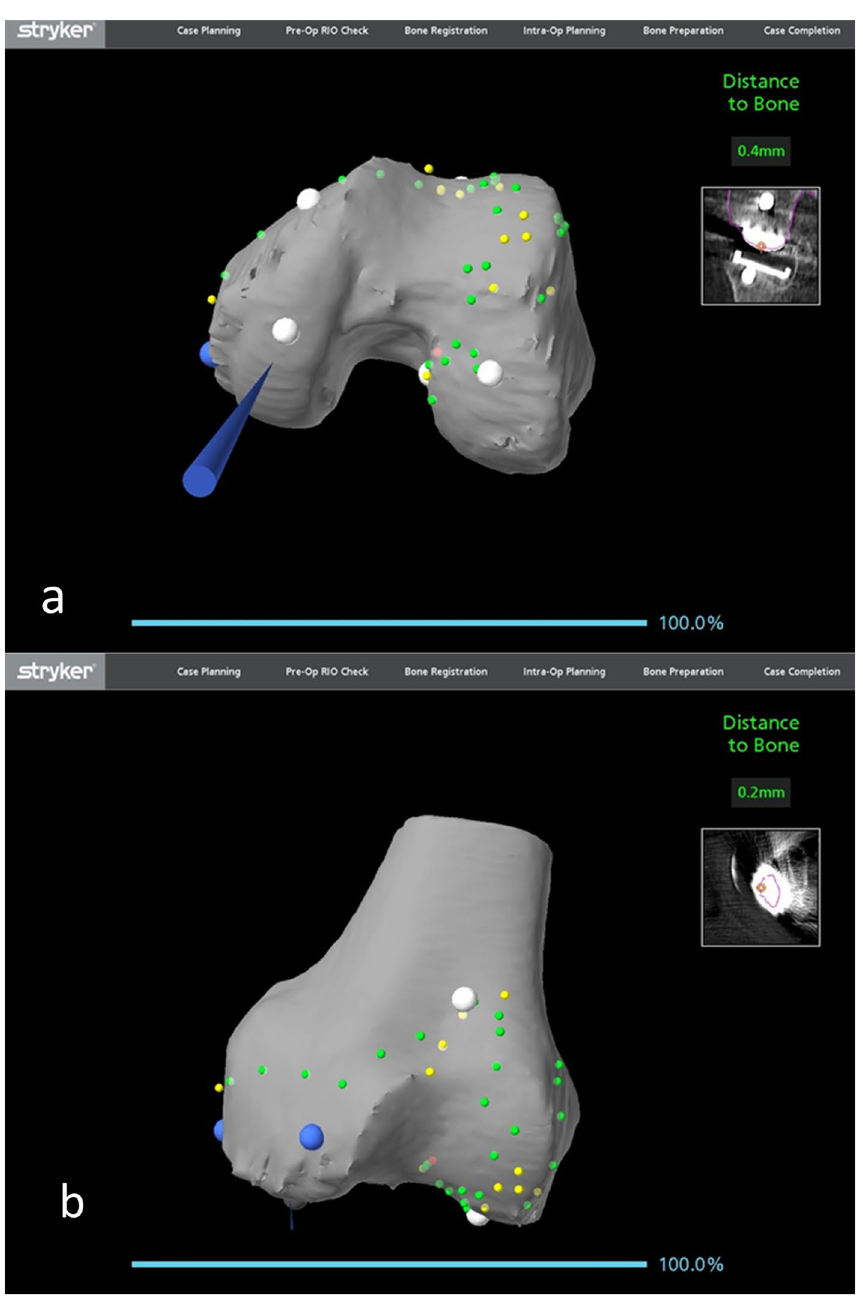
Fig. 13 Femoral bony landmark registration with a medial unicompartmental knee femoral component in